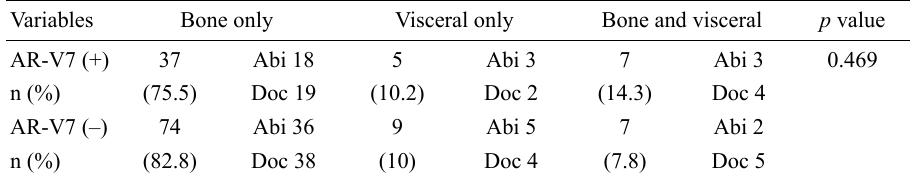
Table 1. The distribution of metastatic sites.